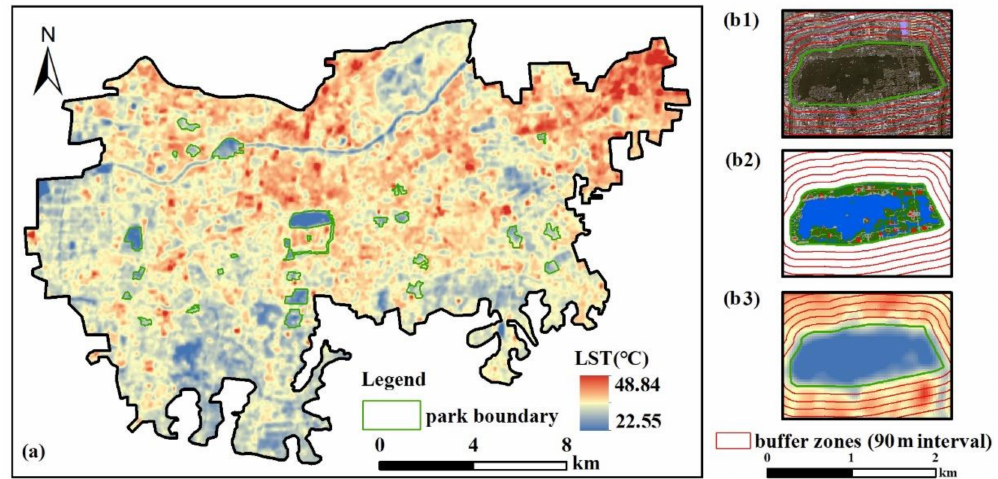
Figure 5. ( a ) The distribution of the average LST, ( b1 ) the GF-2 image of Daming Lake Park, ( b2 ) the land cover of Daming Lake Park, and ( b3 ) the LST of Daming Lake Park and its surroundings.